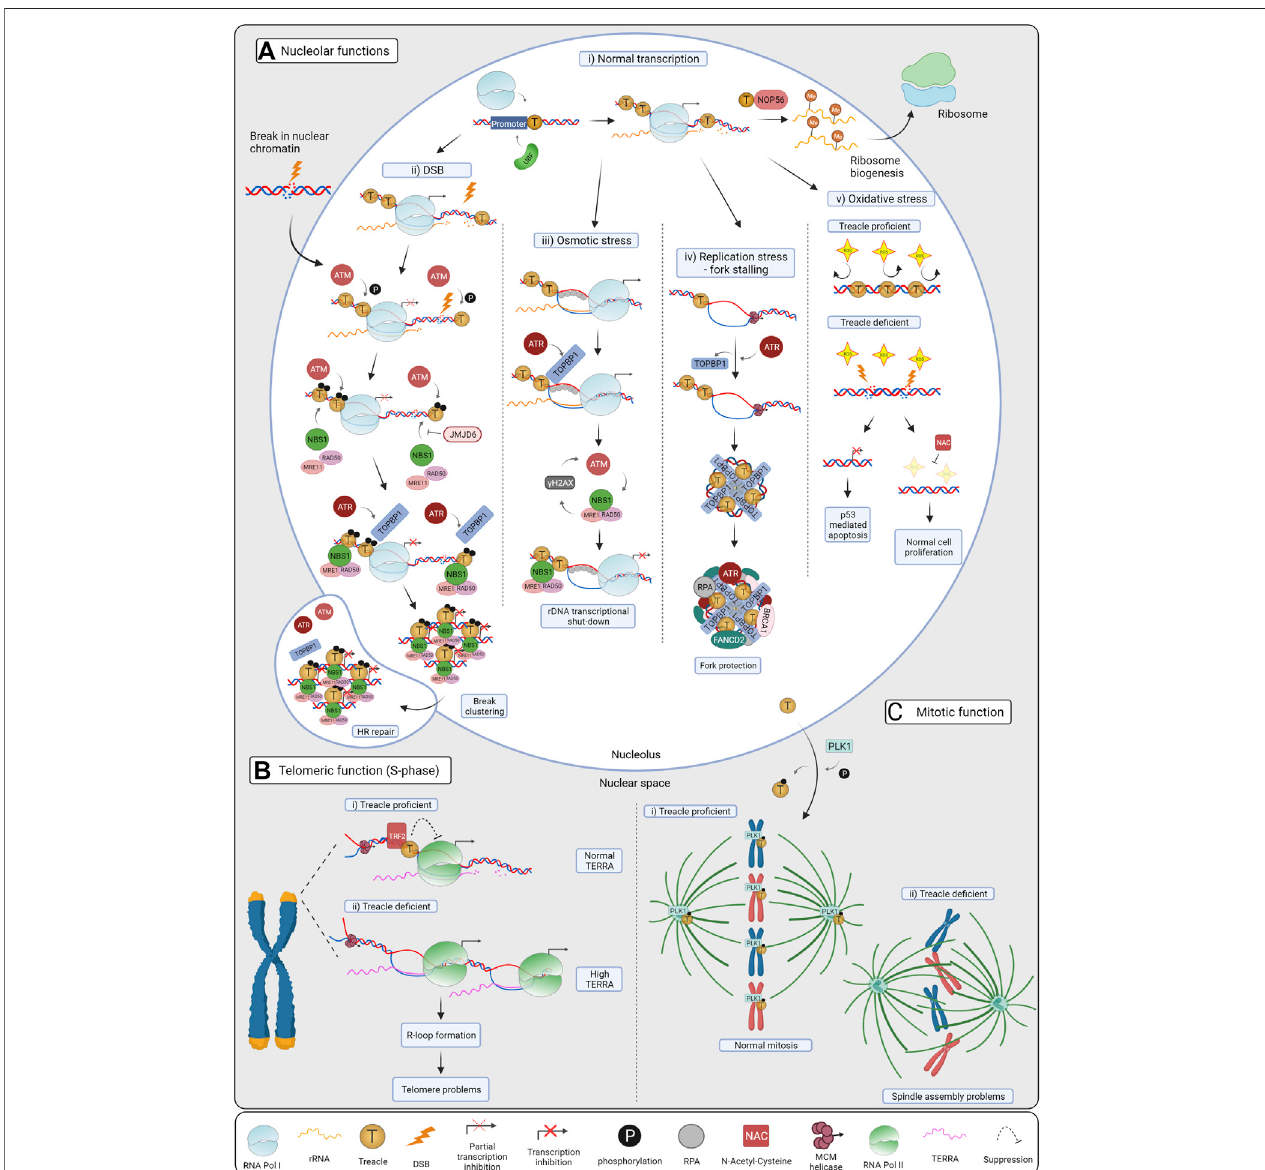
FIGURE2| CellularfunctionsofTreacle. (A) Treaclenucleolarfunctions:i)Normaltranscription.TreaclepromotesrRNAtranscriptionbyrecruitingPolIandUBFto the rDNA promoter. By interacting with NOP56, it also mediates rRNA methylation, essential for mature rRNAs and ribosome production. ii) DSB repair. Upon DSB induction ATM becomes activated and phosphorylates Treacle, leading to Pol I transcriptional inhibition. Treacle in turn recruits the MRN complex and TOPBP1, which then activates ATR. ATR activation is required for complete rDNA transcriptional shut-down, it promotes break clustering, and their eventual translocation to nucleolarcaps.Inthecaps,breaksbecomeaccessibletoHRfactorsandrepaired.iii)Osmoticstress.Hypoosmotic stressleadstothestabilization ofnucleolarR-loops, recruiting RPA and TOPBP1. Treacle is indispensable for TOPBP1 recruitment, and subsequent ATR activation. ATR is the main kinase controlling the response, but ATMactivationandNBS1werealsorequiredforPolIinhibition.iv)Replicationstress(RS).RSleadstoforkstallingintherDNA,andactivatesATR,whichinturnmediates TOPBP1 recruitment through Treacle. TOPBP1 and Treacle form large foci, and promote the recruitment of RS factors, such as RPA, BRCA1 and FANCD2 in the nucleoli. By these means, stalled forks are protected, and RS-mediated rDNA breaks are minimized. v) Oxidative stress. Neuroepithelial cells have high levels of ROS, harmful to the DNA. The rDNA is normally protected by Treacle, however, upon Treacle de fi ciency, high levels of ROS lead to DSB formation, and consequent rRNA transcriptional inhibition. Nucleolar stress leads to the stabilization of p53 and apoptosis, causing craniofacial defects in TCS patients. When Treacle de fi cient cells are treated with the ROS scavenger NAC, less DNA damage and apoptosis are observed and craniofacial features are preserved in mice. (B) Treacle telomeric functions. i) TreacleisrecruitedtothetelomericrepeatsbyTRF2,anditcontrolsTERRAtranscriptioninS-phase.TreacleinteractswithPolIIandregulatesitstranscription.ii)TERRA levels increase upon Treacle depletion, leading to R-loop formation and telomere problems. When Treacle is absent, more Pol II associates with the telomeres, and accelerates TERRA transcription. (C) Treacle mitotic function. i) Treacle is phosphorylated by PLK1 and localizes to the kinetochores and centrosomes, promoting normal mitosis. ii) In the absence of Treacle, cells have problems with mitotic spindle assembly, chromosome alignment and mislocalization of PLK1. Created with BioRender.com.